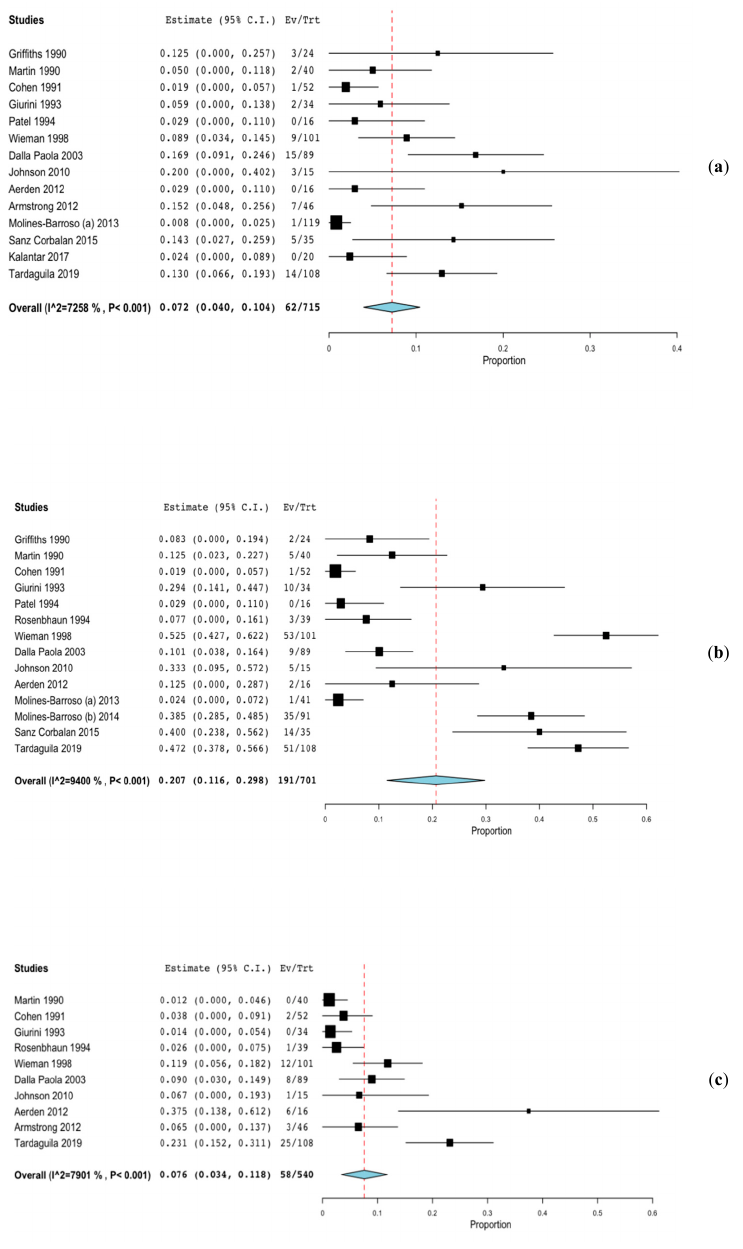
Figure 2. Forest plot—proportion of recurrence, reulceration and amputation. ( a ) Recurrence, ( b ) Reulceration, ( c ) Amputation.